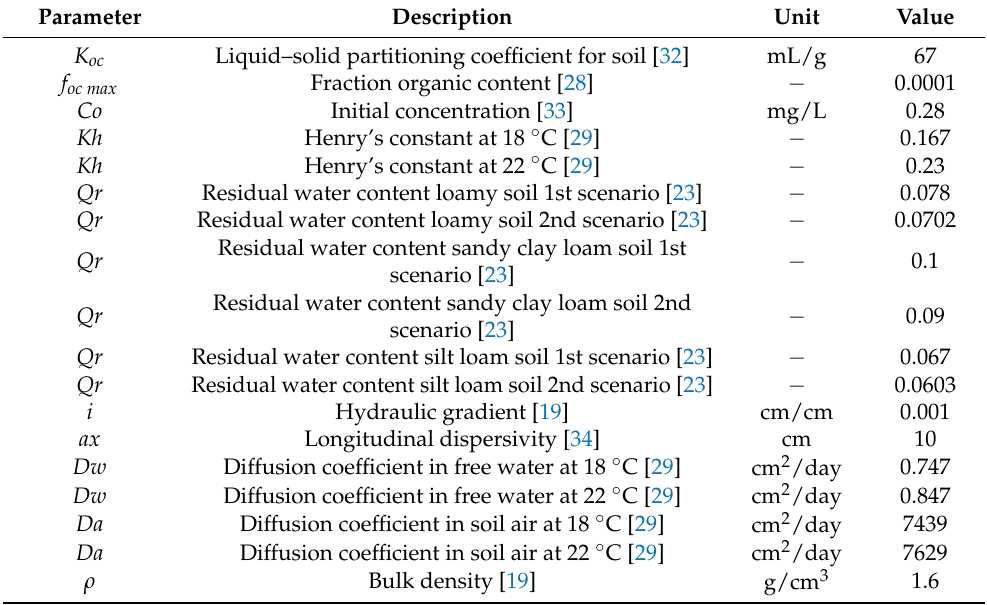
Table 1. Model parameters.